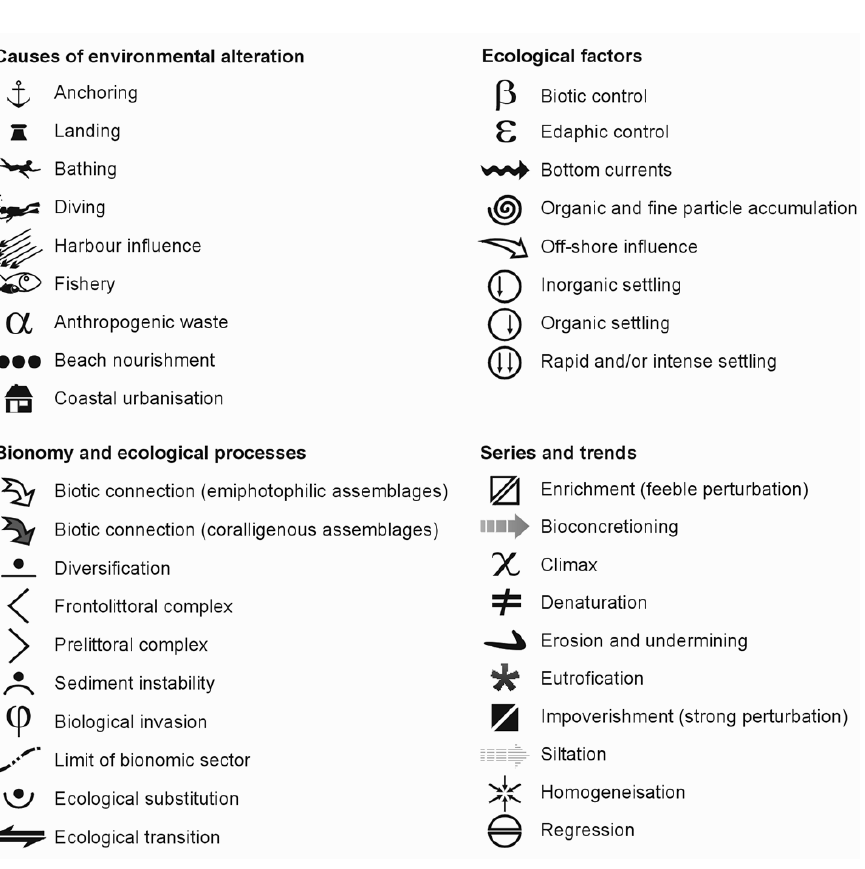
Figure 6. Examples of symbols of degradation and risk of the marine territory. Maps that use these symbols can be freely downloaded, at their full size, from the SEAMap site